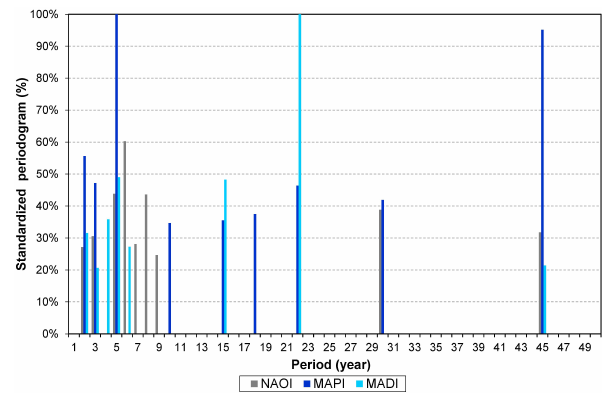
Fig. 10. Largest periodogram peaks for the NAOI, MAPI and MADI time series.